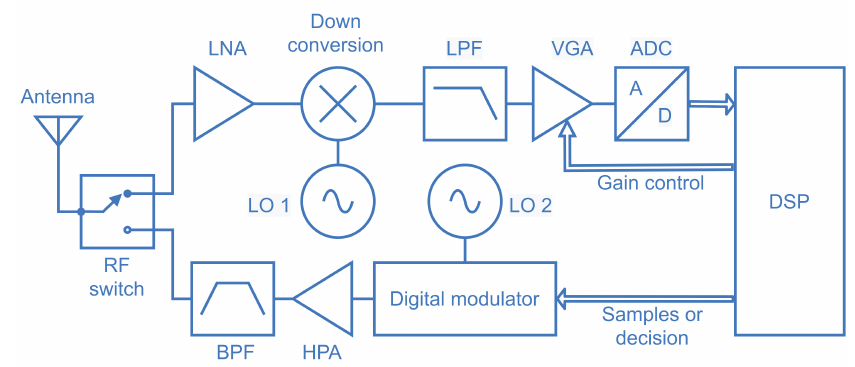
Figure 3. Block diagram of a receiver architecture for spectrum